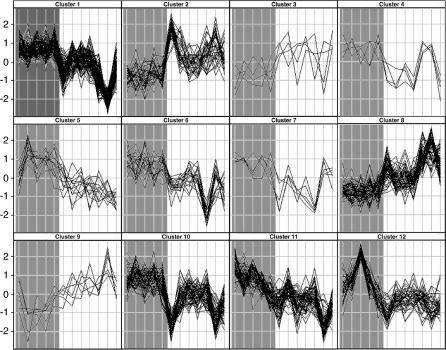
Profiles of Gene Expression in the Uterine Cervix from Women before or after the Onset of LaborEach panel shows profiles of the genes within one of the clusters determined jointly by K-means and hierarchical clustering. On the
x-axis, samples from individual patients are arranged and represented by vertical lines. Non-labor samples (gray background) are shown on the left and labor (white background) on the right. The
y-axis represents the level of gene expression as a number of standard deviations from the mean of all observations for each gene (
z-score).